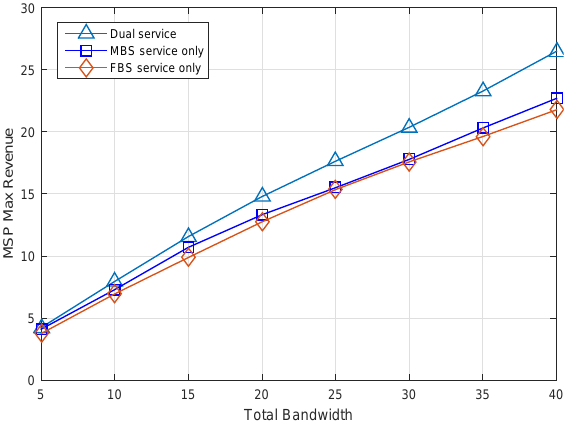
Figure 6. Macrocell service provider (MSP) max revenue versus total bandwidth under different service